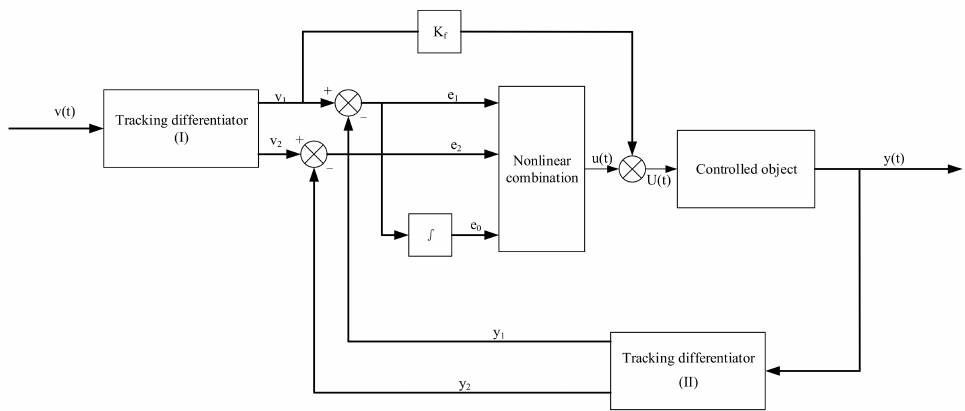
Figure 3. Structure diagram of the nonlinear feed-forward PID